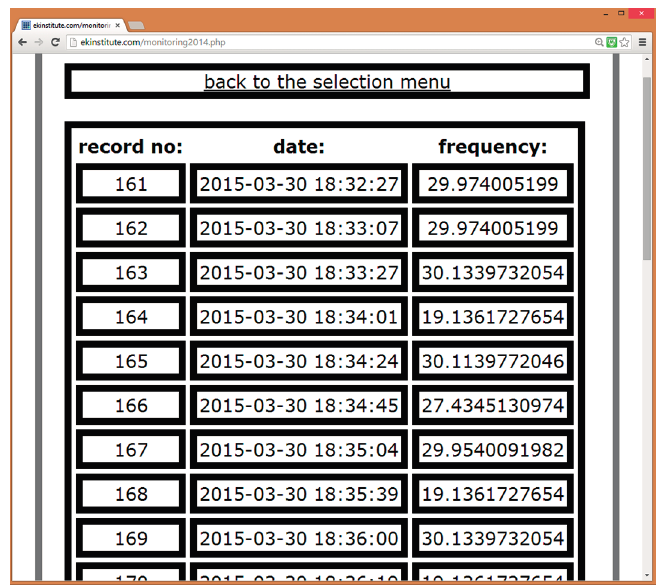
Figure 4. Screenshot from the web interface showing the SHM results